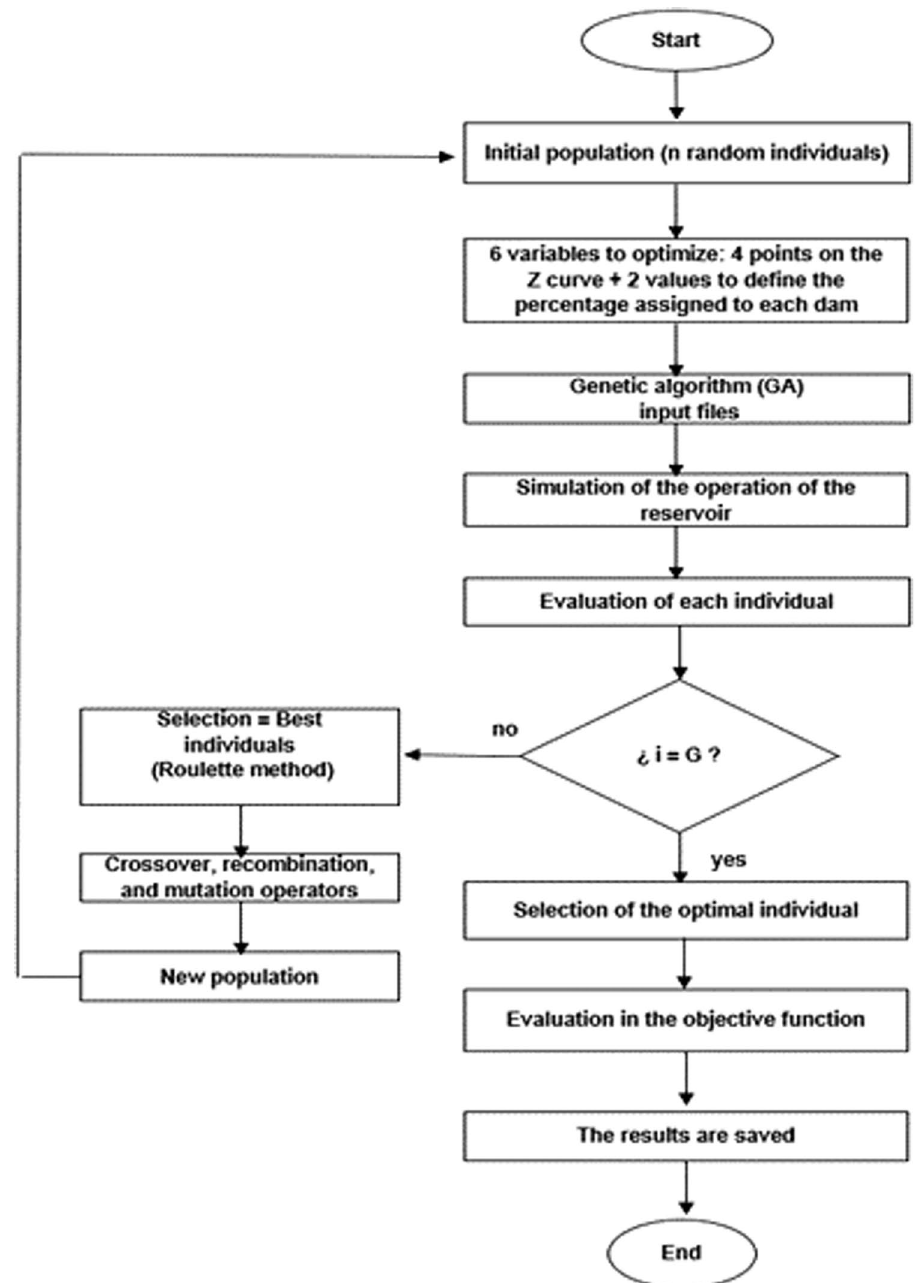
Fig. 3 Flow diagram of the genetic algorithm applied to the simulation of the reservoir